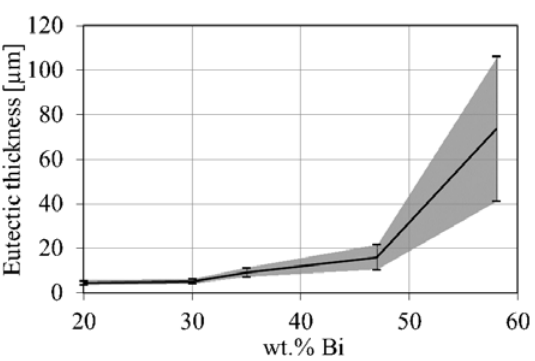
Figure 6. Eutectic phase thickness obtained from µ -XCT measurements as a function of Bi content. Error bars indicate the standard deviation of eutectic